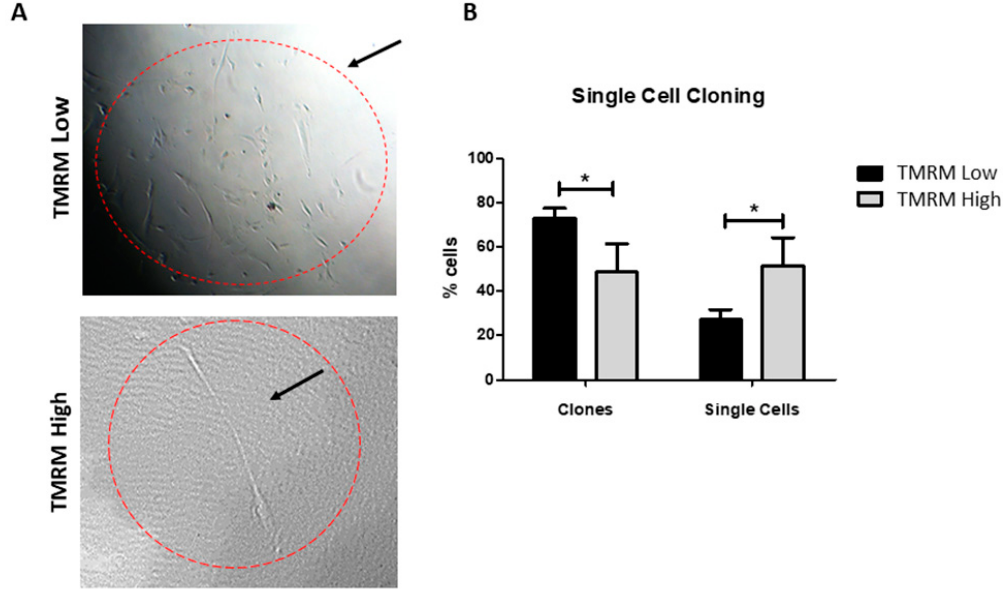
Figure 11. Single cell cloning of TMRM-low and high cells. Representative light microscopy images of TMRM-low and high cells after 1 week of single cells cloning assay (left panel). Bar graph identify the numbers of clones and single cells present after 1 week of culture for both the considered populations. Data are represented as mean ± SD. n = 3 per group. Statistical differences were calculated significant as * p < 0.05, determined by Student’s t-test.